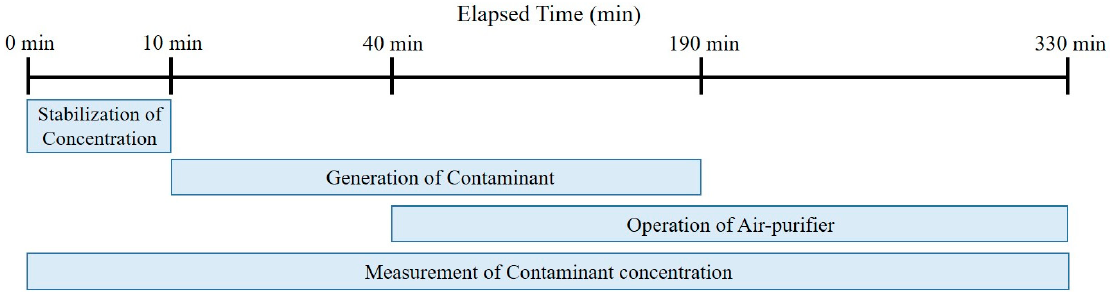
Figure 11. Experiment Progress (Real-Time Occupant Tracking Method and Zone Controlling Method). Int. J. Environ. Res. Public Health 2020 , 17 , x